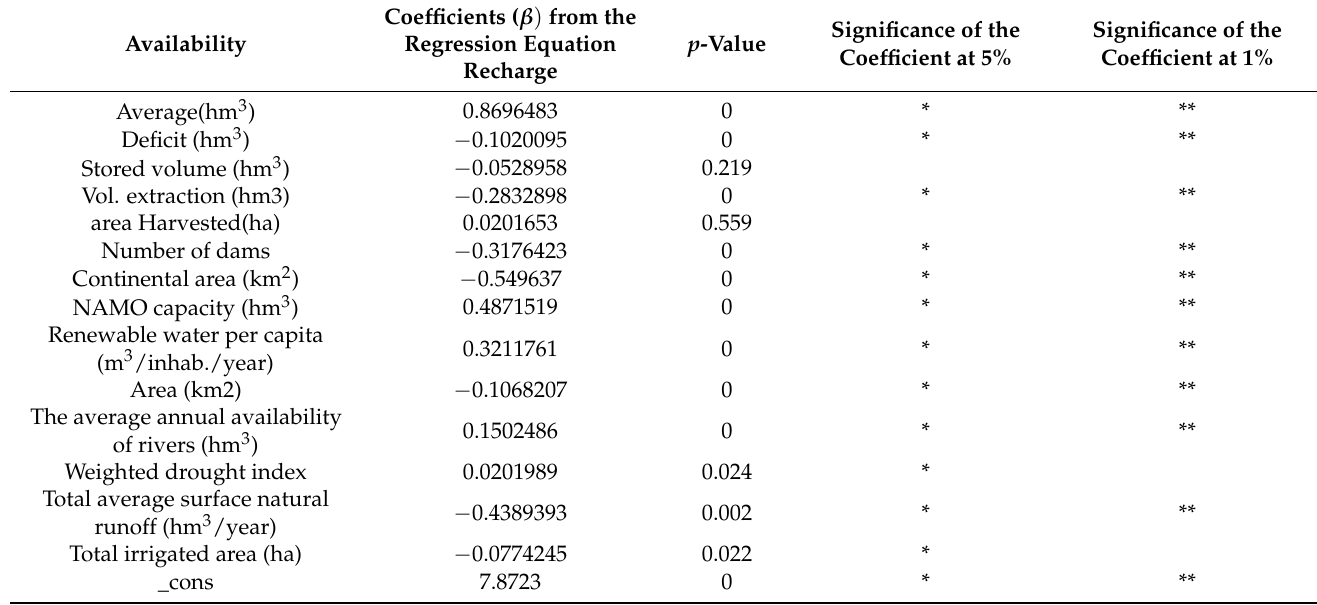
Table 8. Coefficients and their statistical significance values ( p -values, significant at 5% and 1%) referring to the model developed from the forward perspective, introducing significant variables to the model from a p -value less than 0.05, model E. Coefficients ( β ) from the Significance of the Significance of the p -Value Availability Regression Equation Coefficient at 5% Coefficient at Recharge